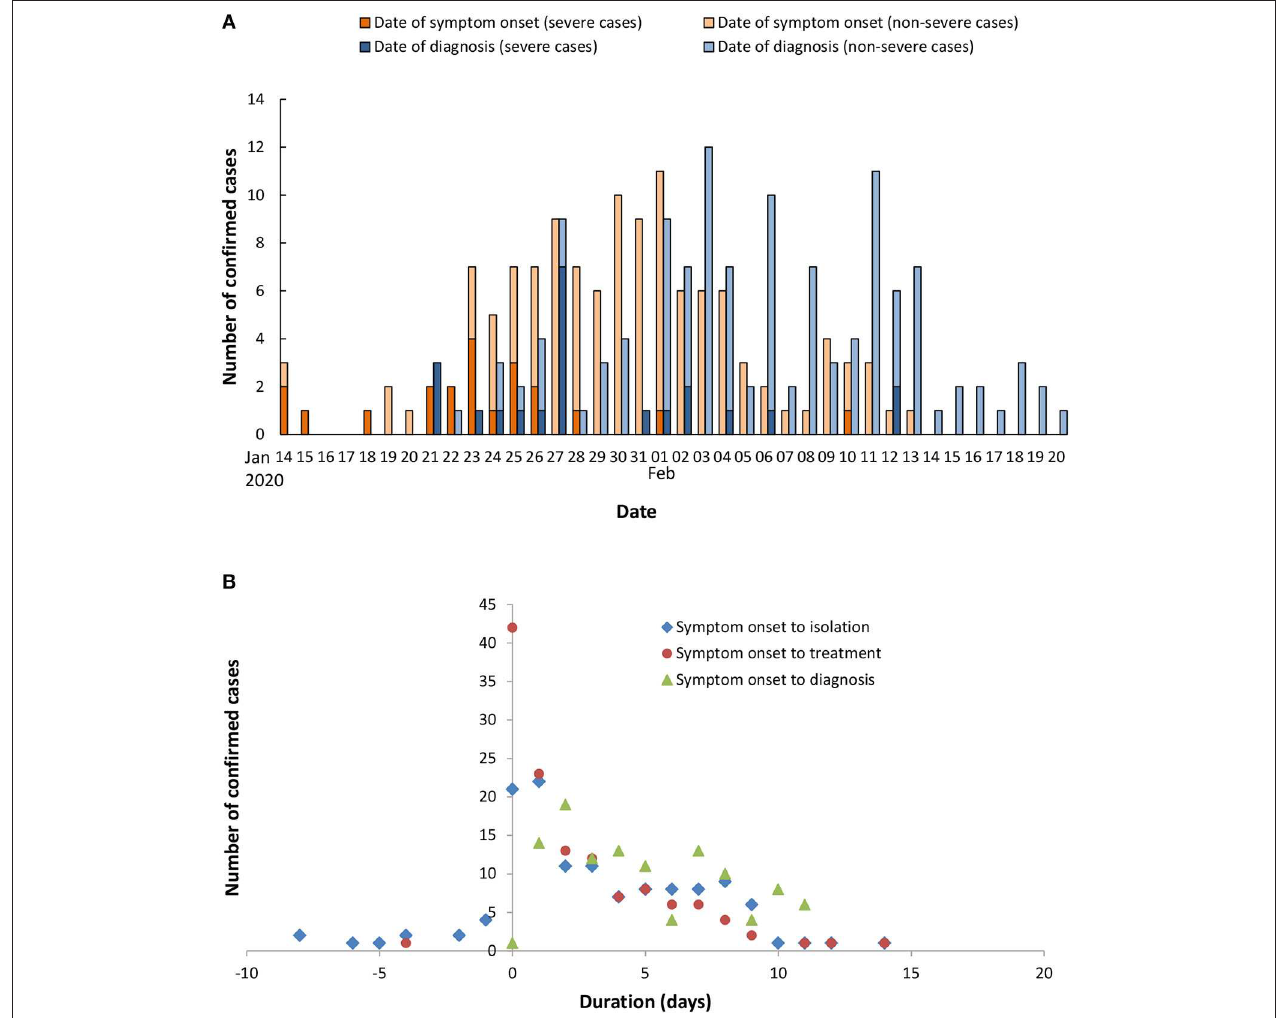
FIGURE 1 | Temporal distribution of confirmed COVID-19 cases in Tianjin. Epidemic curves of confirmed cases were drawn according to the date of onset and the date of diagnosis (A) . The distribution of cases was plotted based on specific duration since the onset date of symptoms (B)